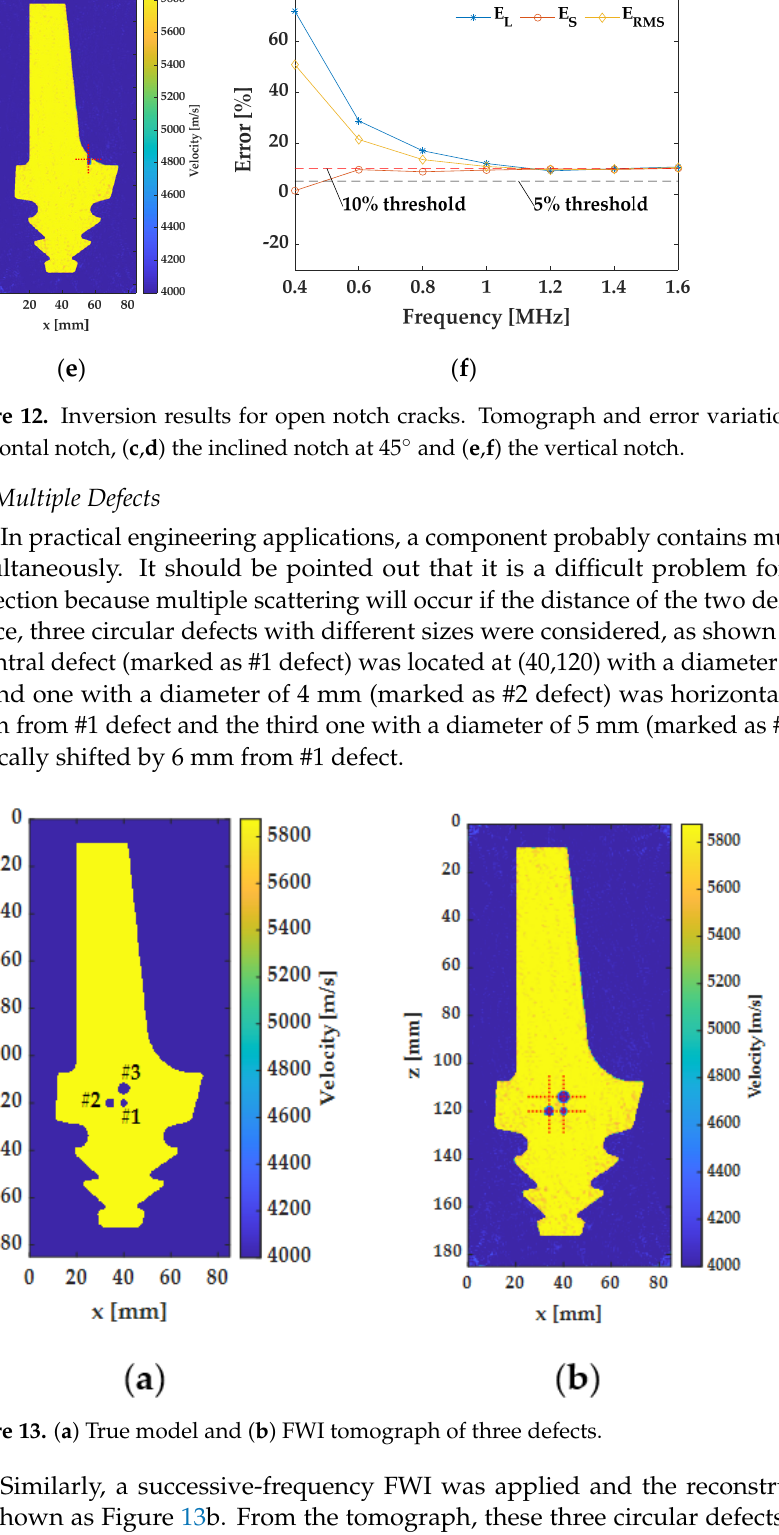
Figure 13. ( a )True model and ( b ) FWI tomograph of three defects.